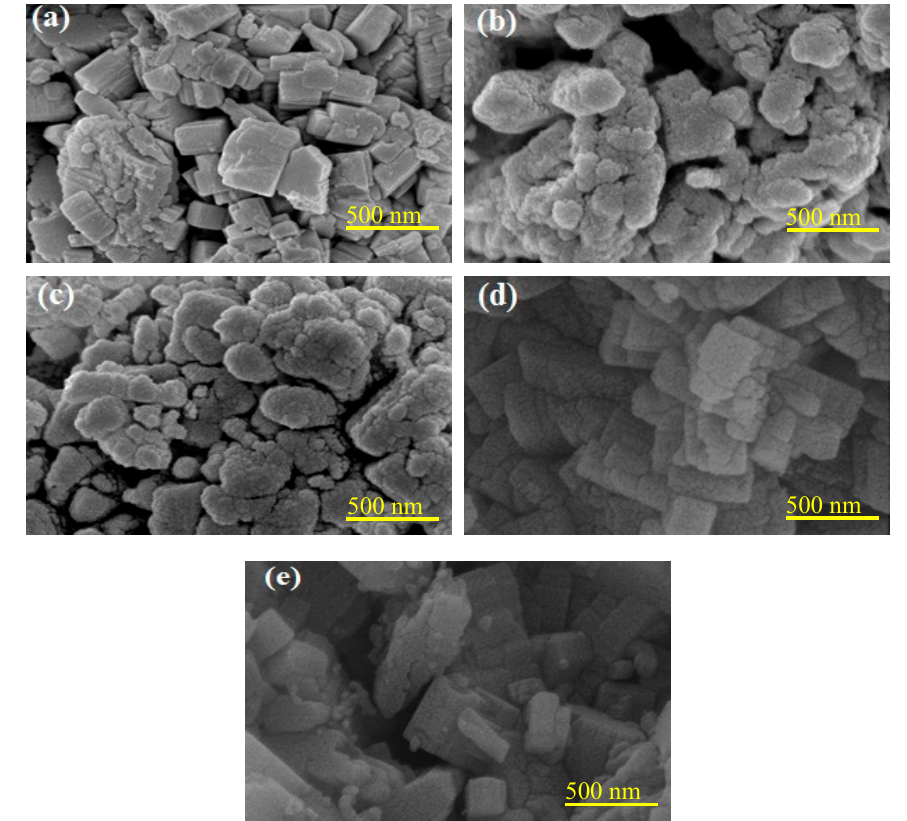
Figure 4. SEM images for ( a ) ZSM ‐ 5, ( b ) ZSM ‐ 5 ‐ Na, ( c ) ZSM ‐ 5 ‐ C, ( d ) ZSM ‐ 5 ‐ T and ( e ) ZSM ‐ 5 ‐ CT.